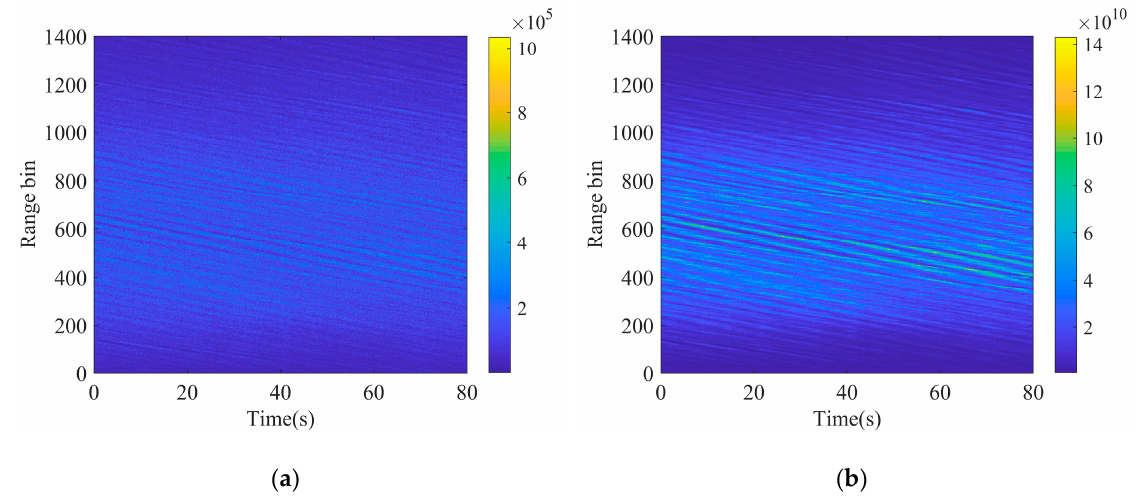
Figure 2. The amplitude-range-time of real data: ( a ) Original clutter; ( b ) Original texture separated from clutter. from